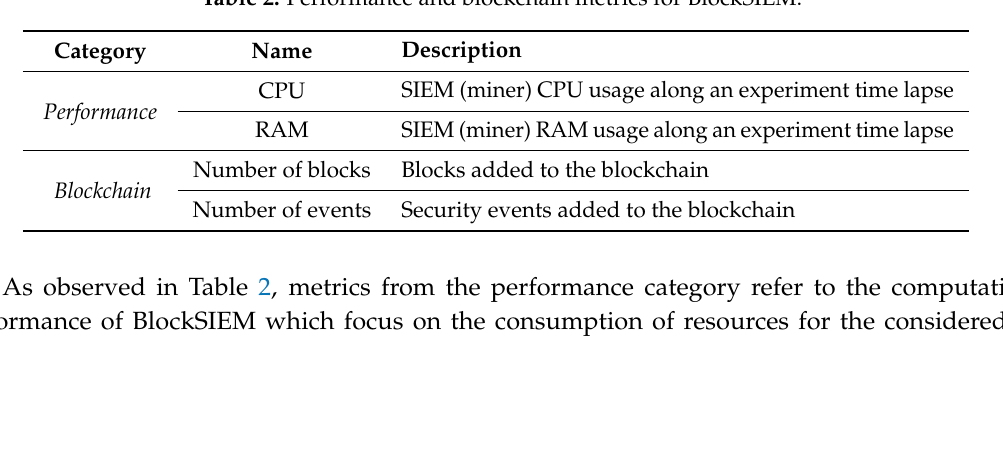
Table 2. Performance and blockchain metrics for